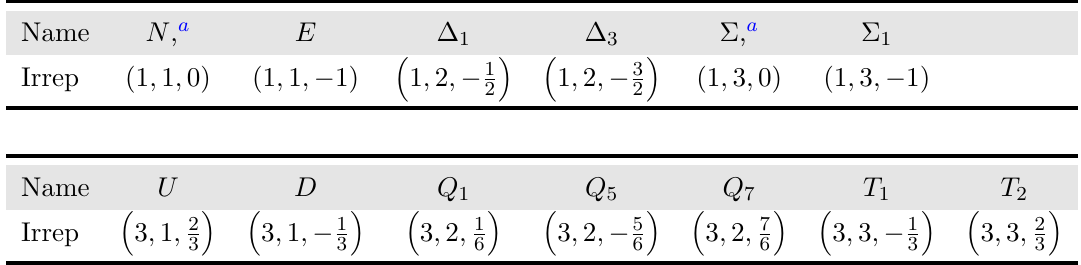
× SU(2) × U(1) and also the C L Y